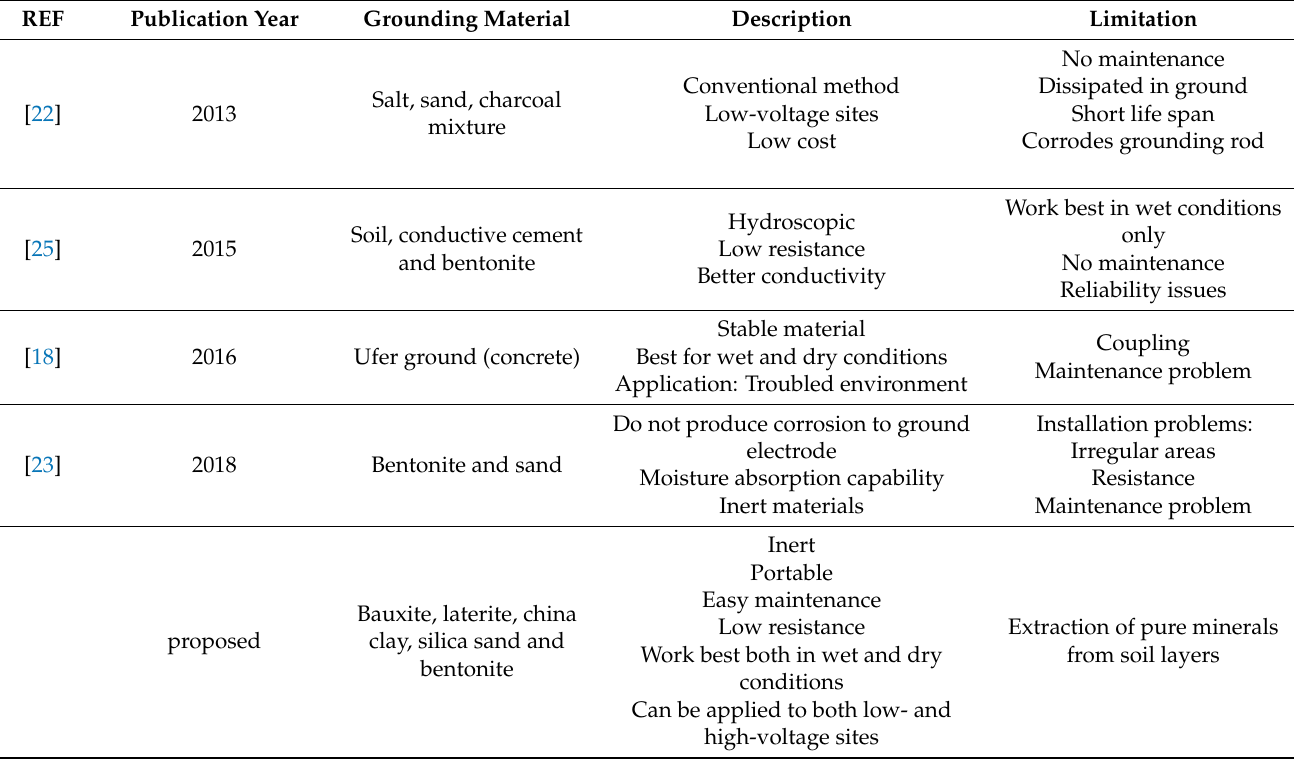
Table 1. Grounding material